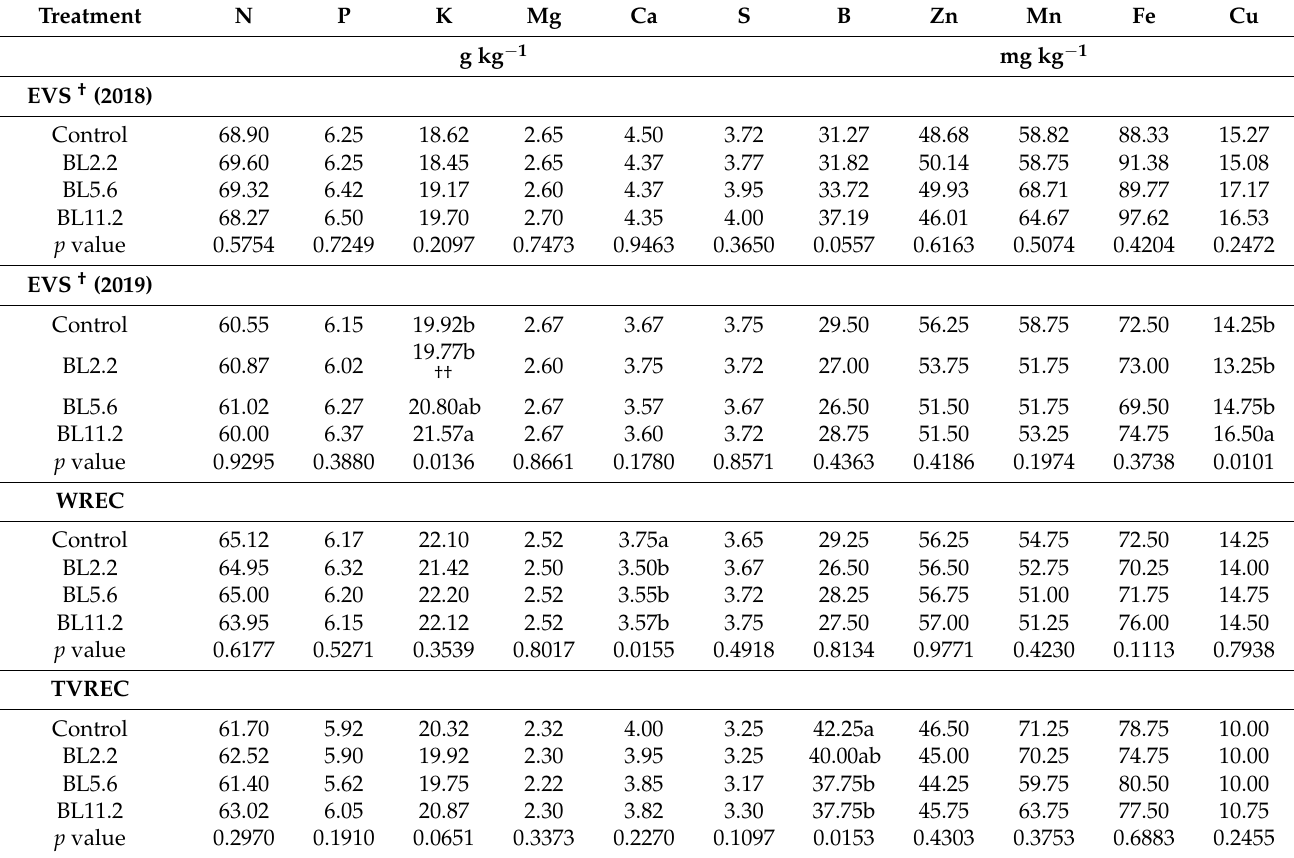
Table 4. Total seed nutrient concentrations of soybean fertilized with broiler litter (BL) measured across experimental sites.